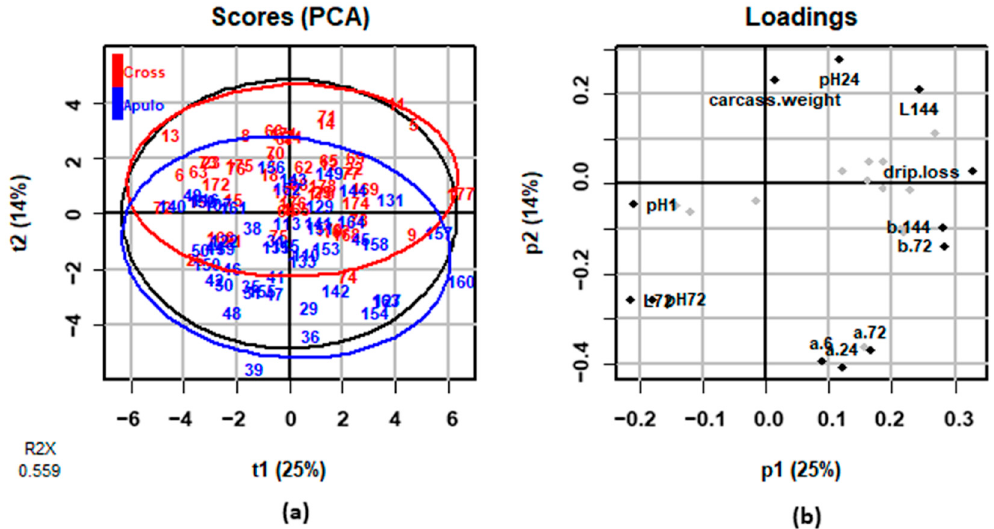
Figure 4. Results of principal components analysis (PCA) on the meat quality traits: ( a ) score plots for principal component 1 (t1) and principal component 2 (t2) of Apulo-Calabrese (blue) and crossbreeds (red) samples; ( b ) loadings plot with the weights of variables included in principal component 1 (p1) and principal component 2 (p2).